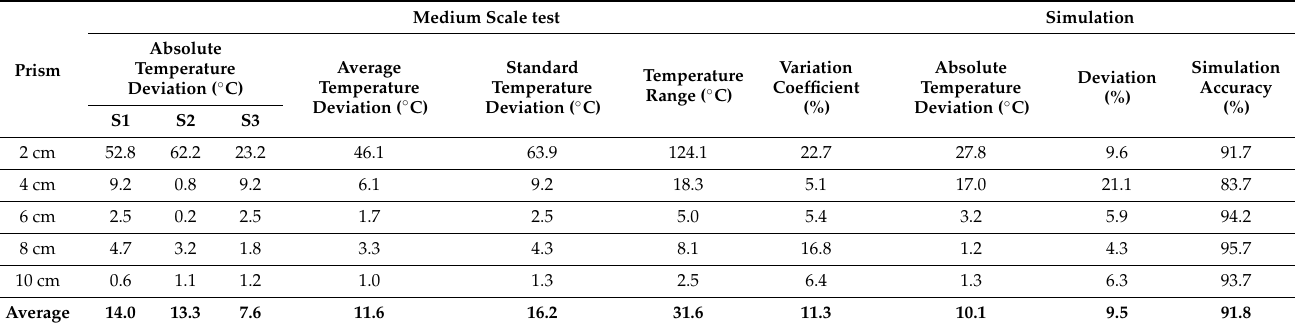
Table 1. Statistical indicators—Norway spruce prisms.